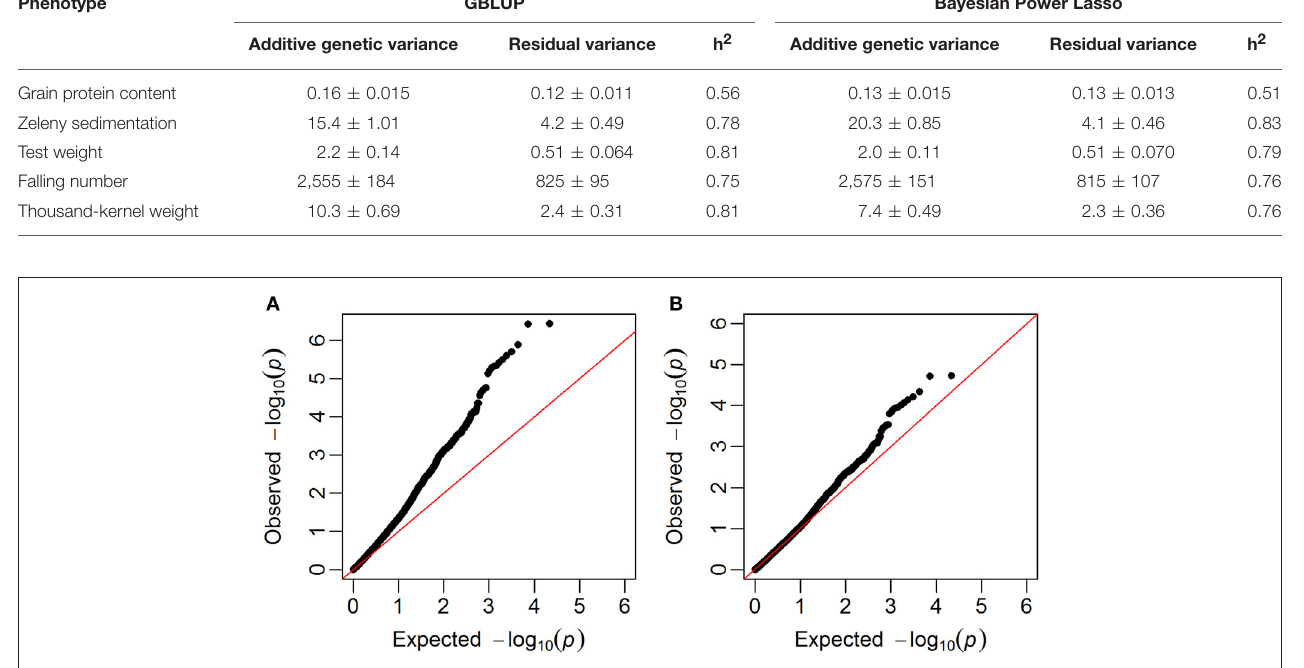
TABLE 4 | Variance components, their standard errors, and narrow sense genomic heritabilities estimated from the GBLUP and from the Bayesian Power Lasso models. Phenotype